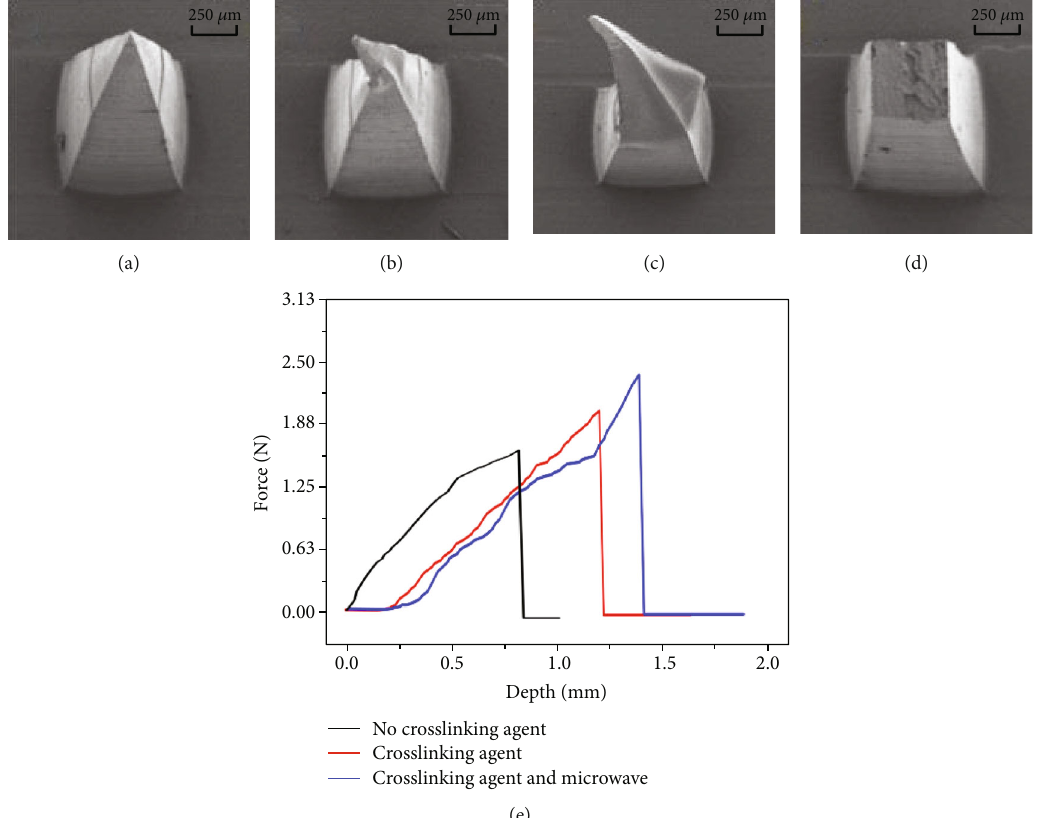
Figure 9: (a) – (d) show the deformation of the hydrogel-crosslinked microneedles obtained by microwave-assisted drying under the pressure of 0 N (a), 15N (b), 30N (c), and 40N (d). Curve (e) between the pressure experienced by the hydrogel microneedles and the depth of the downward extrusion under di ff erent conditions, including no crosslinking agent, crosslinking agent, crosslinking agent, and